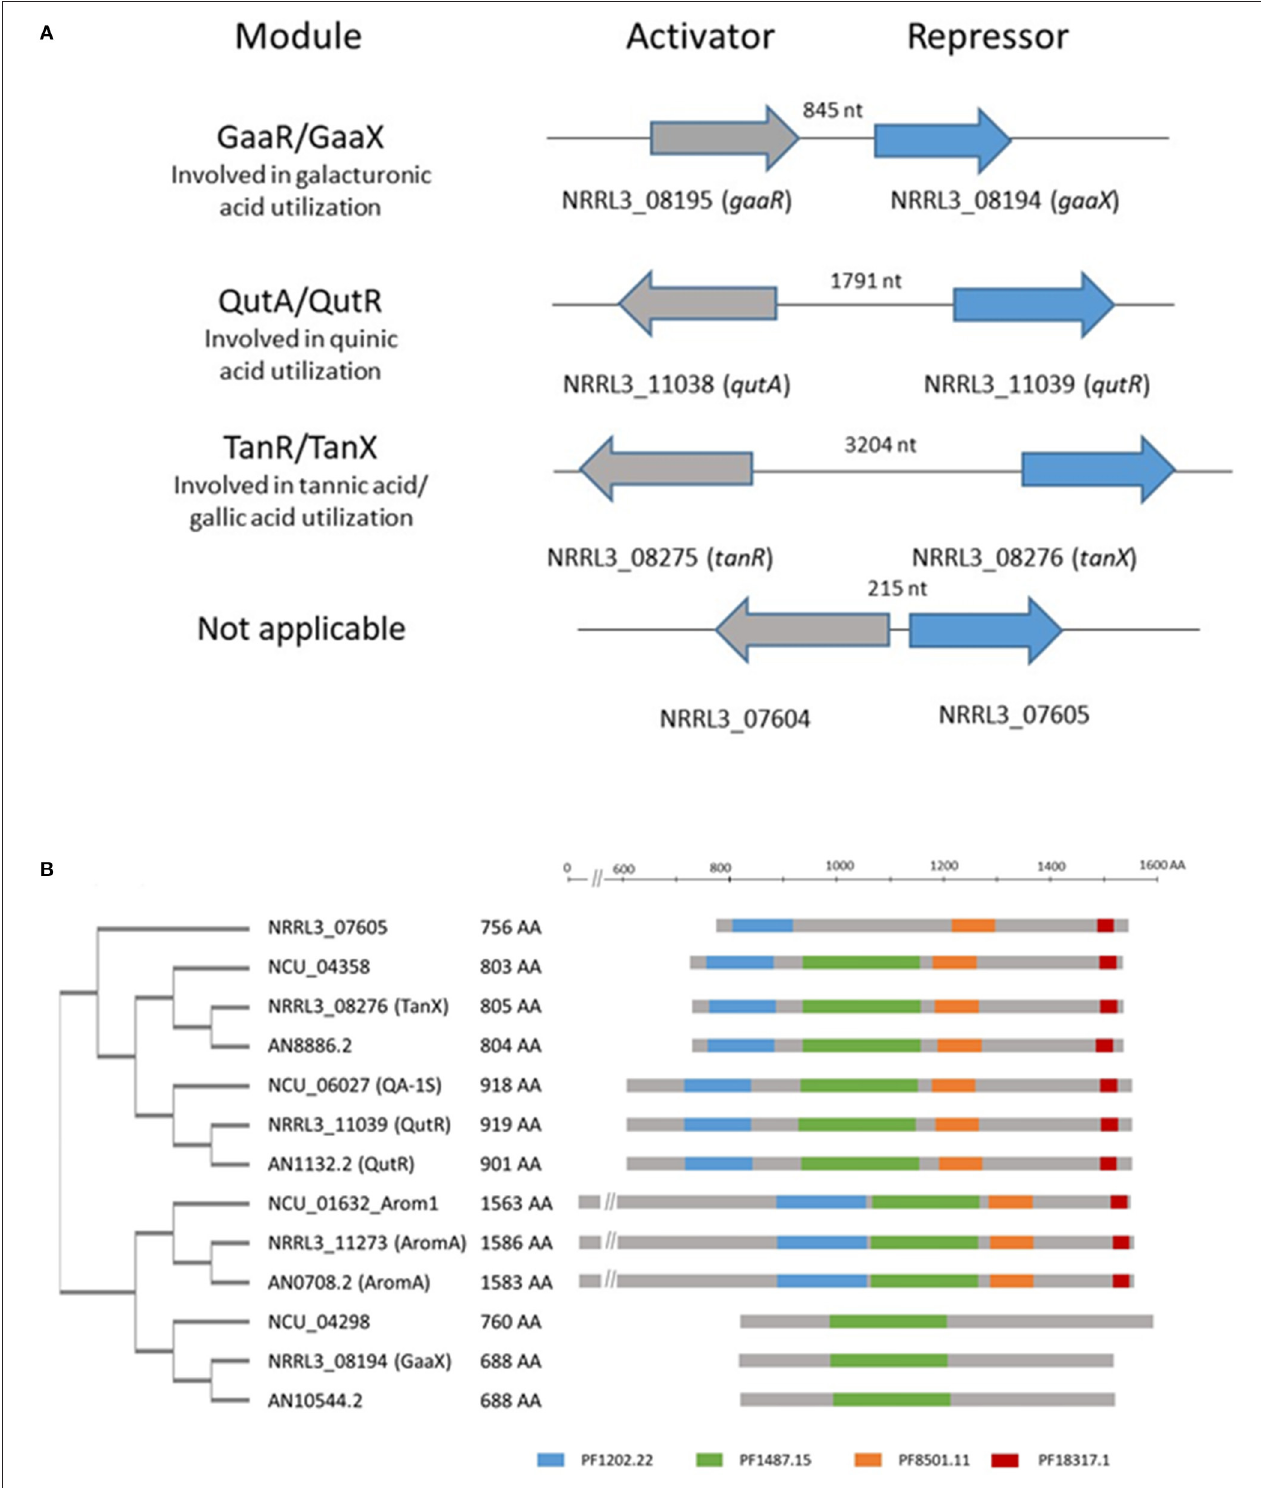
FIGURE 2 | Schematic overview of the genomic organization of activator/repressor modules in the genome of A. niger and the presence of PFAM domains in putative repressor proteins. (A) Four modules consisting of an activator and a putative repressor protein are present in the genome of A. niger . The genes ecoding the activator